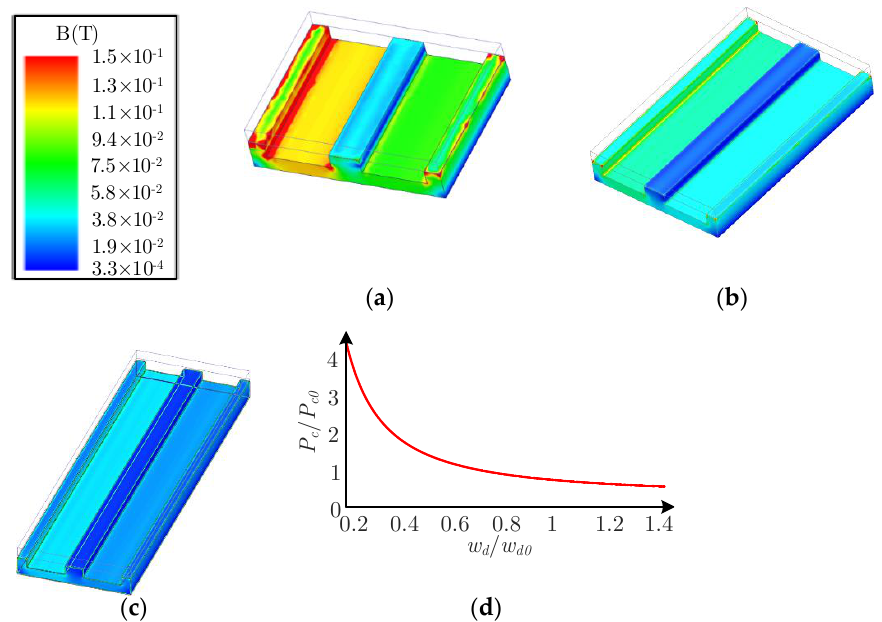
Figure 10. Distribution of magnetic flux density with different w d : ( a ) w d = 50.8 mm; ( b ) w d = 101.6 mm; ( c ) w d = 203.2 mm; ( d ) core loss with w d .